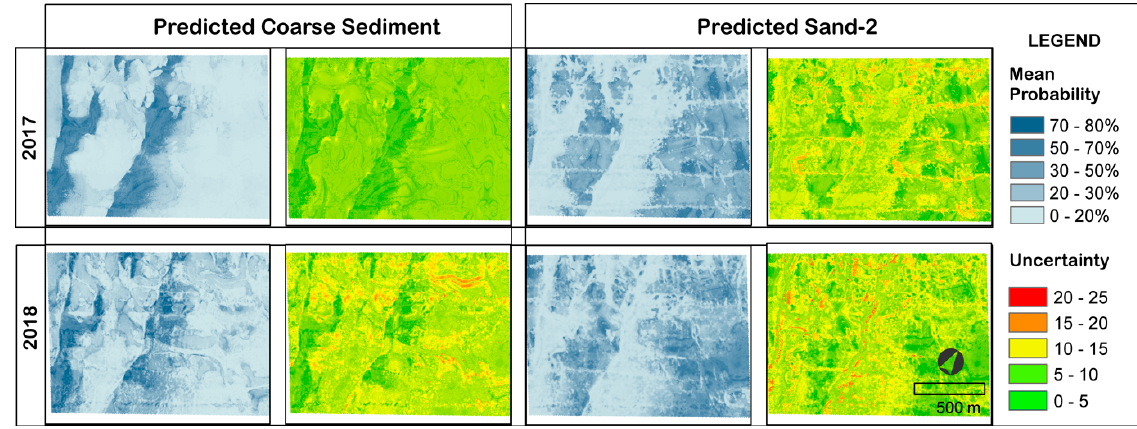
Figure 7. Predicted areas of coarse sediment and sand-2 classes in H5 for the year 2017 and 2018.